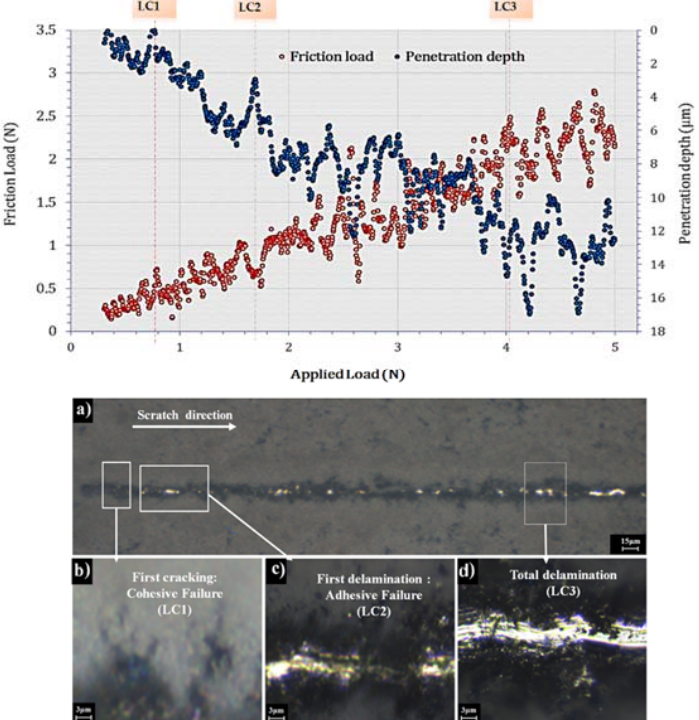
Figure 9. Friction load and penetration depth as a function of the applied load and the correspon- donding optical micrographs of scratch tracks of as-deposited HAP coating: ( a ) scratch track; ( b ) first cracking; ( c ) first delamination; ( d ) total delamination.